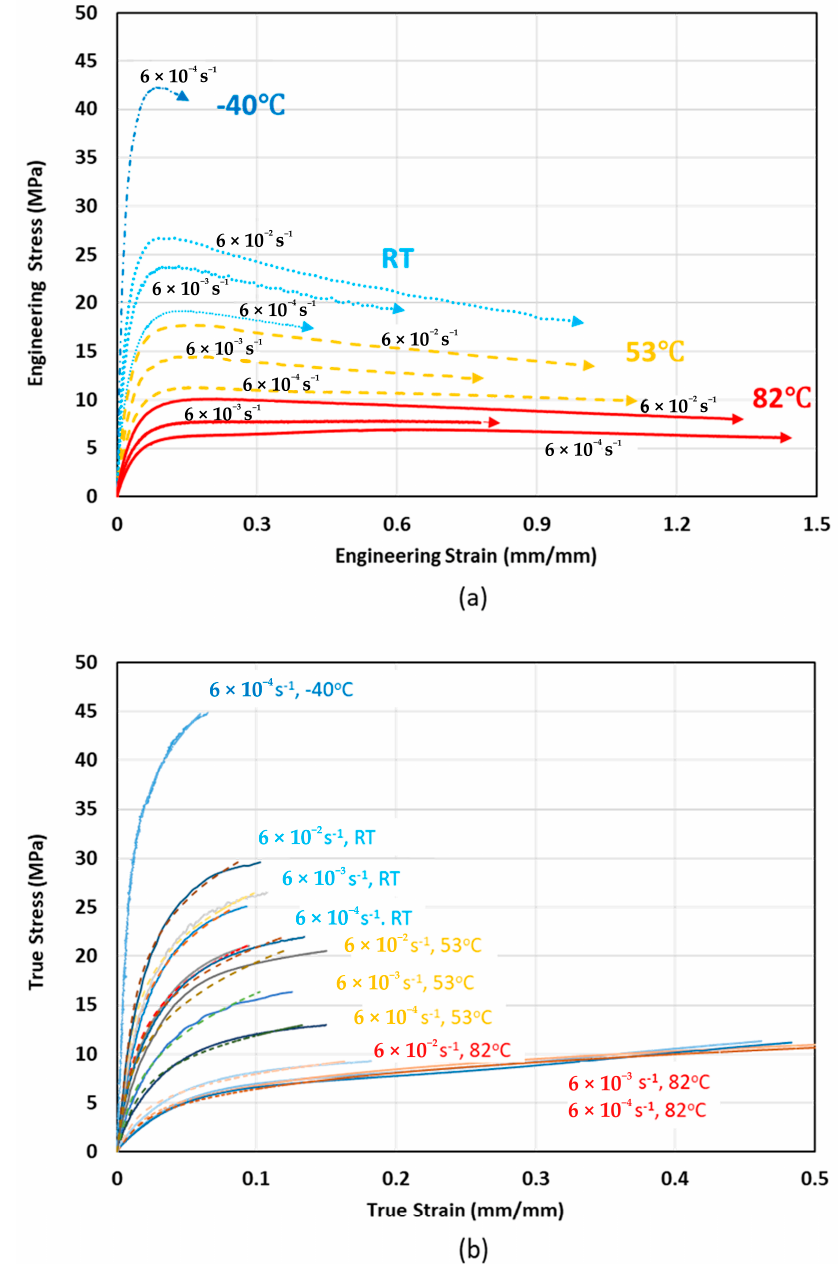
Figure 6. ( a ) Engineering stress-strain curves, and ( b ) true stress-strain curves showing temperature and strain rate e ff ects at di ff erent temperatures and strain